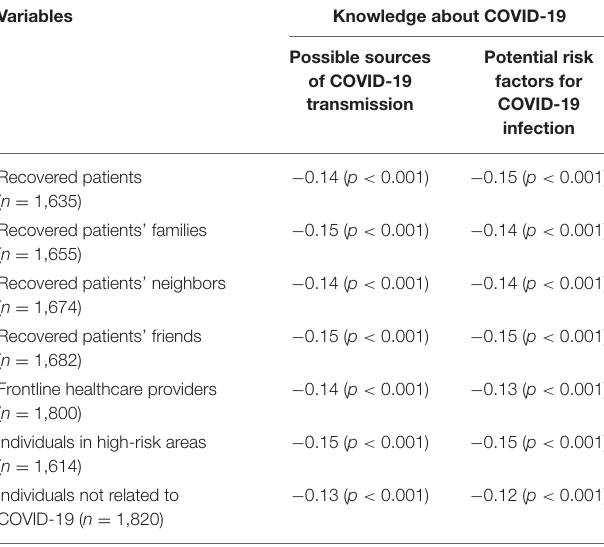
TABLE 7 | Correlations between the knowledge about COVID-19 and the COVID-19-related stigma (stigma score ≤ 3). Variables Knowledge about COVID-19 Possible sources of